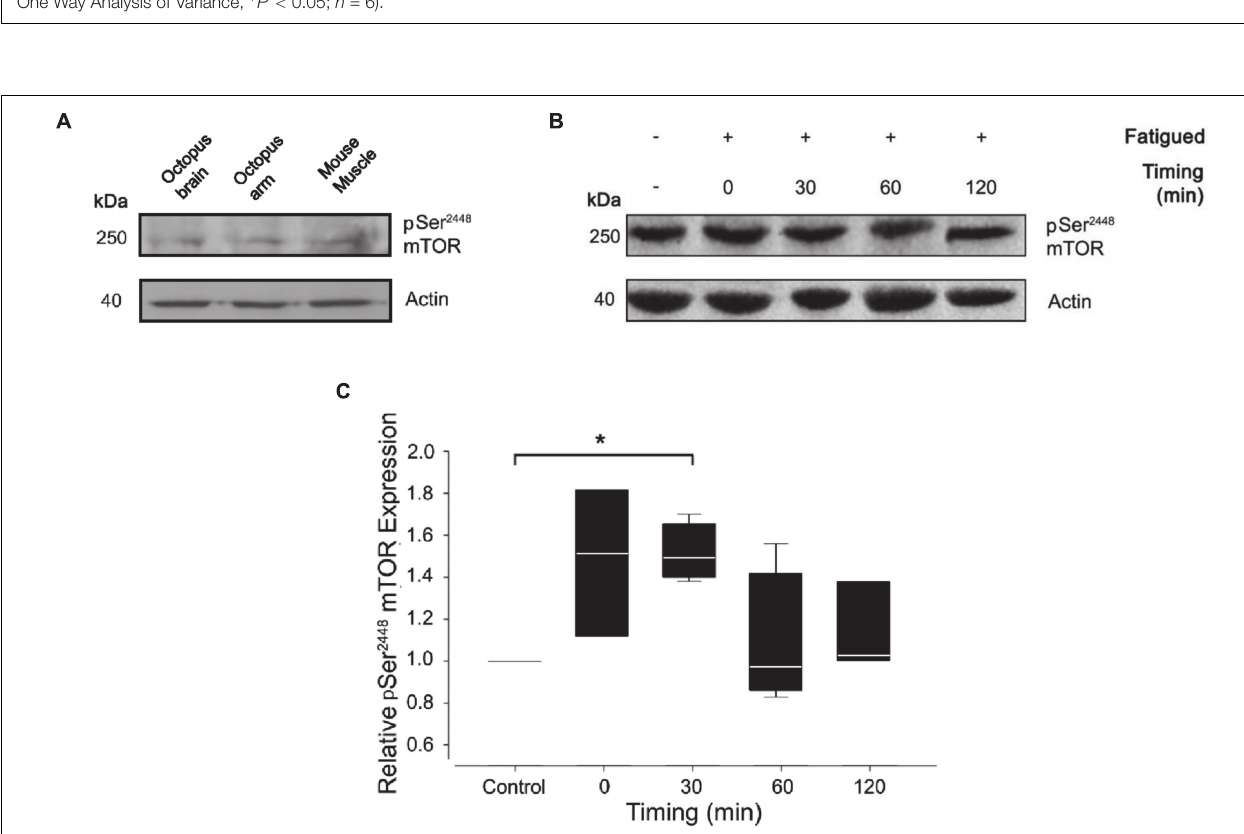
FIGURE 3 | Effect of muscle fatigue induction on mTOR activation. (A) pSer 2448 mTOR and actin antibody validation. Resulting bands were obtained at 250 kDa for pSer 2448 mTOR and at 42 kDa for actin in lysates from octopus brain, octopus arm and mouse muscle. (B,C) Representative experiment (B) and quantification (C) of western blotting analysis of pSer 2448 mTOR expression in control and fatigued samples at different timing post RE. Note that the antibody against pSer 2448 mTOR recognize S2386 in octopus mTOR protein sequence. Data were expressed relative to the control and normalized to β -actin (Kruskal-Wallis One Way Analysis of Variance, Holm-Sidak method, ∗ P < 0.05 versus control; n = 4 for each experimental group).